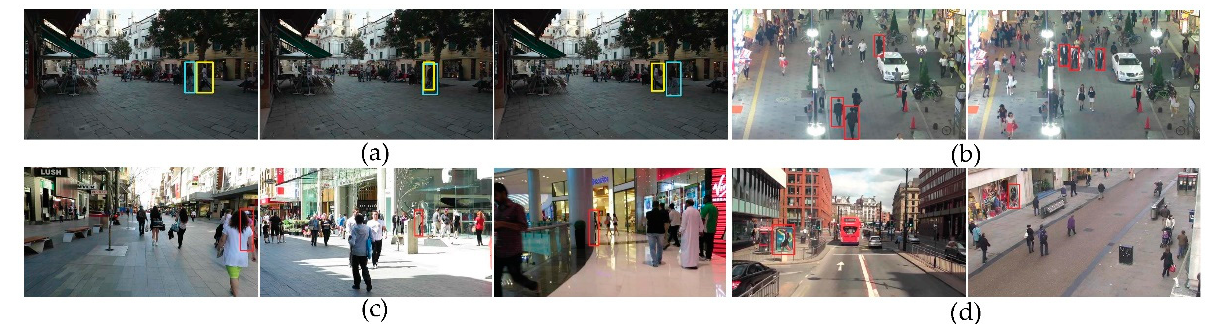
Figure 1. Examples of challenges. ( a ) Interaction between objects. ( b ) Similar objects. ( c ) Occlusion. ( d ) Interference of background.